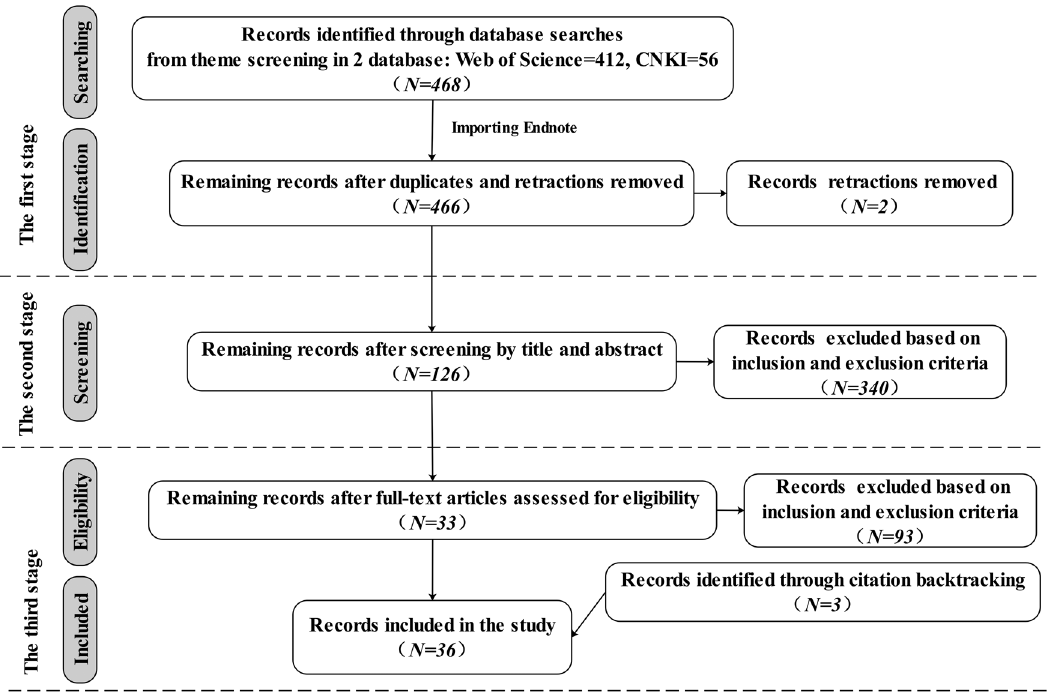
Fig. 1 Flowchart illustrating how the meta-analysis literature was selected. This fl owchart shows the number of records identi fi ed, included and excluded in the